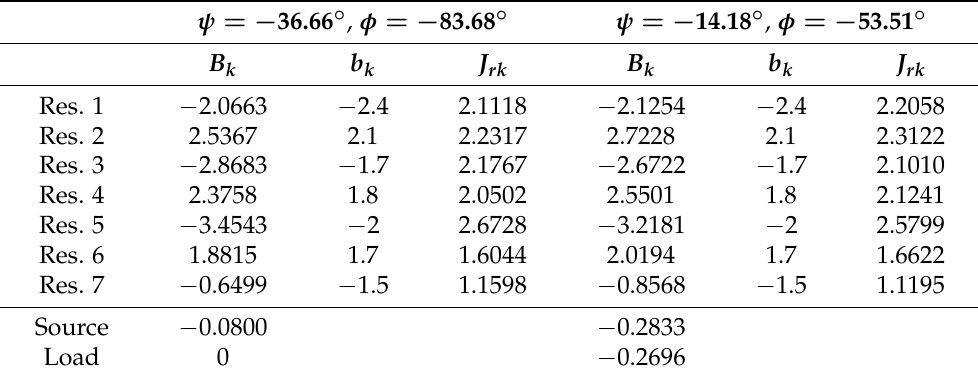
Table 7. Lowpass elements of the synthesized 7th-order ladder filter with phase correction parameters ψ = − 36.66 ◦ , φ = − 83.6889 ◦ and ψ = − 14.18 ◦ , φ = − 53.51 ◦